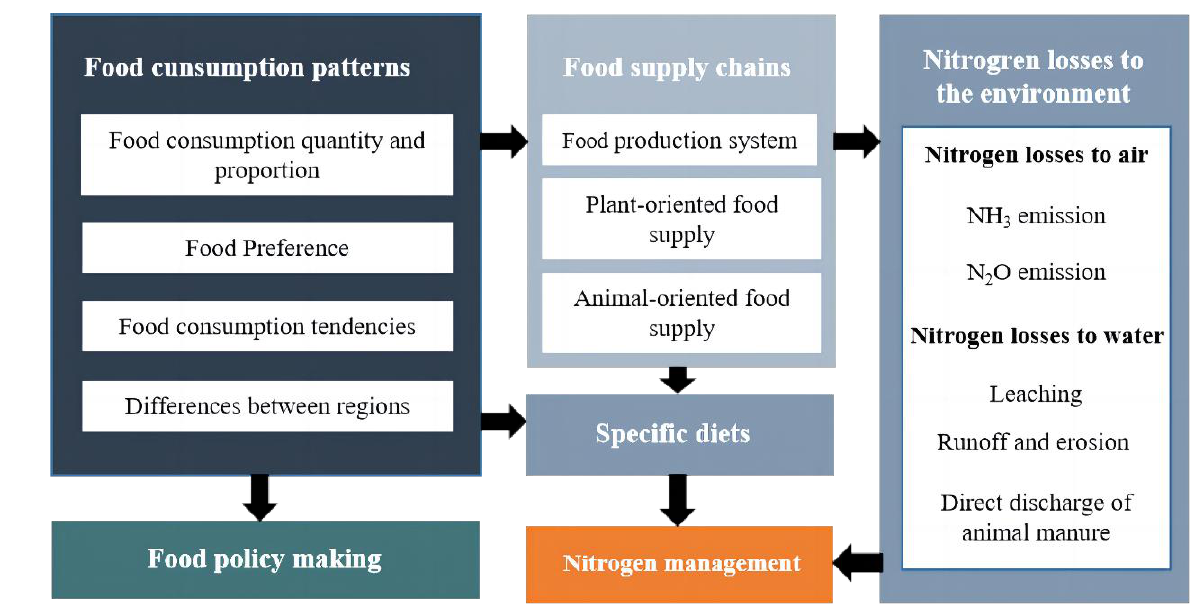
Figure 2. The CFSD and NUFER framework for analyzing the food consumption patterns and N losses.